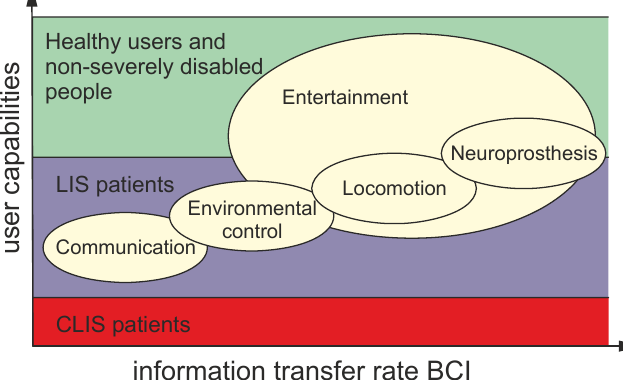
Figure 7. Relationship between BCI application areas, BCI information transfer rates and user capabilities. Horizontal axis: information transfer rate that would make the application controllable. Vertical axis: the degree of